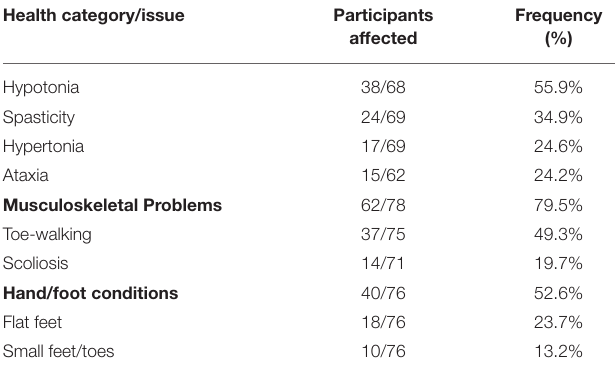
TABLE 5 | Common health issues affecting participants in the WAGR discovery